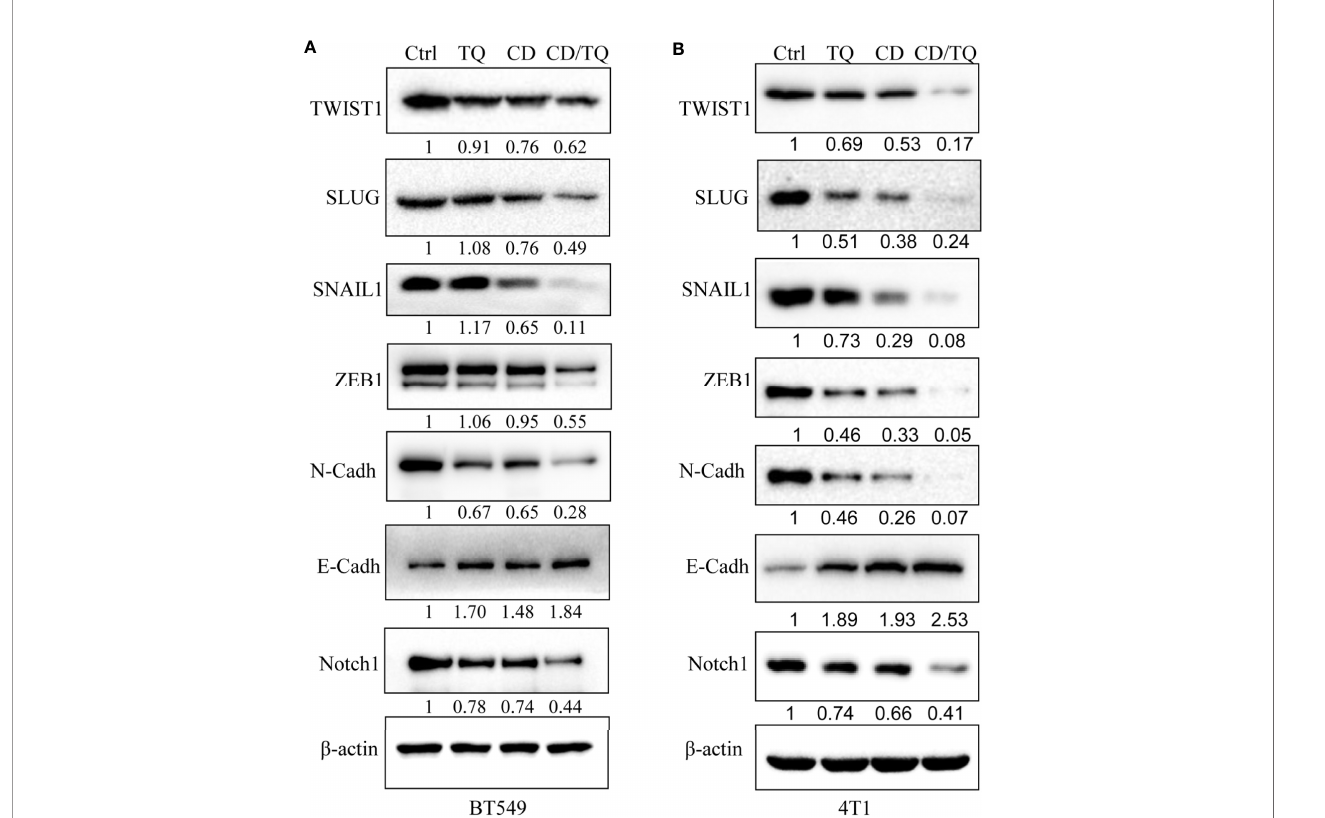
FIGURE 7 | Synergistic effects of cordycepin and thymoquinone on the expression of EMT-TFs (A) and Notch (B) . CD (5 m M), TQ (5 m M), or both treatments for 24 h for Western blot by indicated antibodies. b -Actin was set as an internal control. Results are repeated twice. N-Cadh, N-Cadherin; E-Cadh,